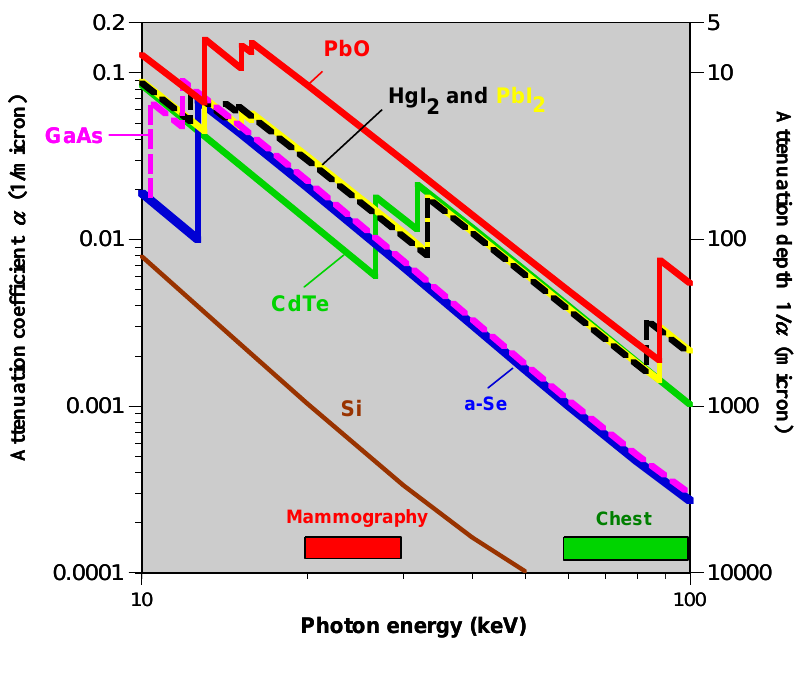
Figure 5. Linear attenuation coefficient  and depth, 1/  vs. photon energy for various photoconductors of